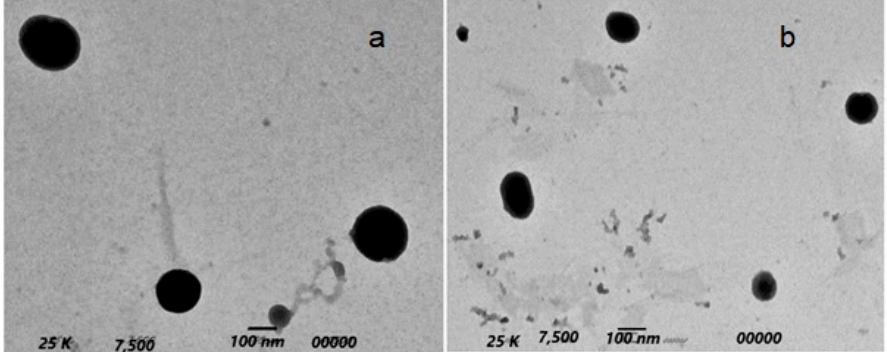
Figure 5. TEM morphology of Oxaliplatin–TGPS niosomes ( a ) and Paclitaxel–TGPS niosomes ( b ).